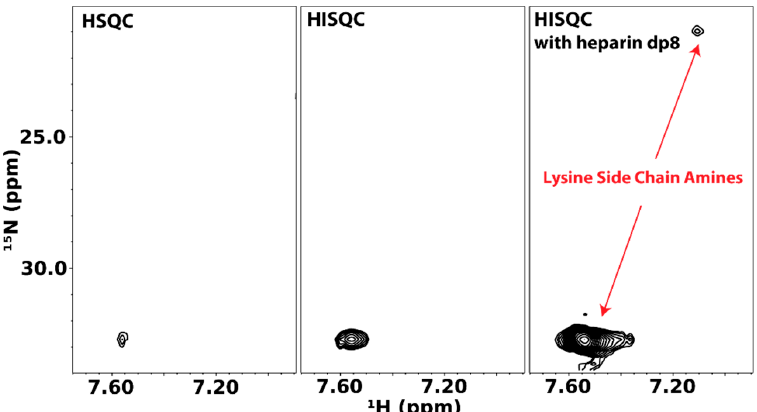
Figure 13. Lysine side chain amine 15 N-HSQC and HISQC of pleiotrophin in the presence and absence of heparin octasaccharides. HISQC of the protein produced significantly stronger signals than HSQC. Addition of heparin octasaccharides also induced appearance of additional signals.